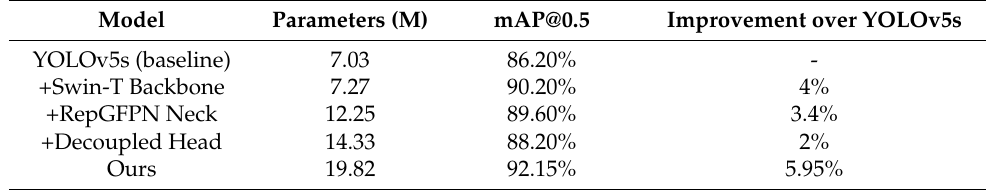
Table 5. Results of ablation